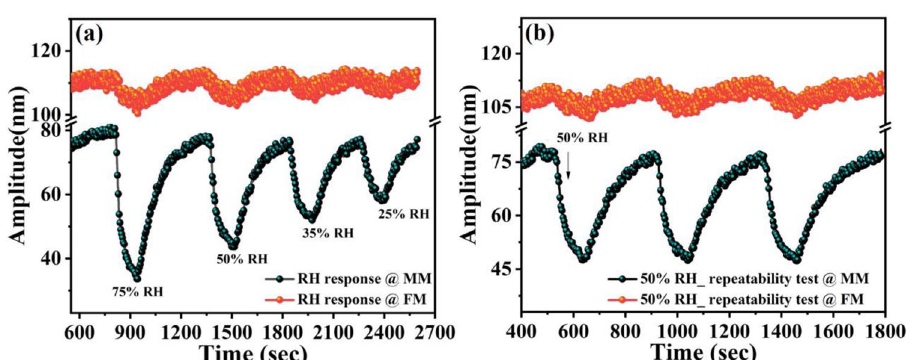
Figure 11. Response of simultaneously actuated vibration modes (V ac = 0.75 V, f o1 30.65 kHz at MM and V ac = 1 V, f o3 163.04 kHz at FM), ( a ) to different levels of relative humidity, and ( b ) simultaneous repeatability test for 50% relative